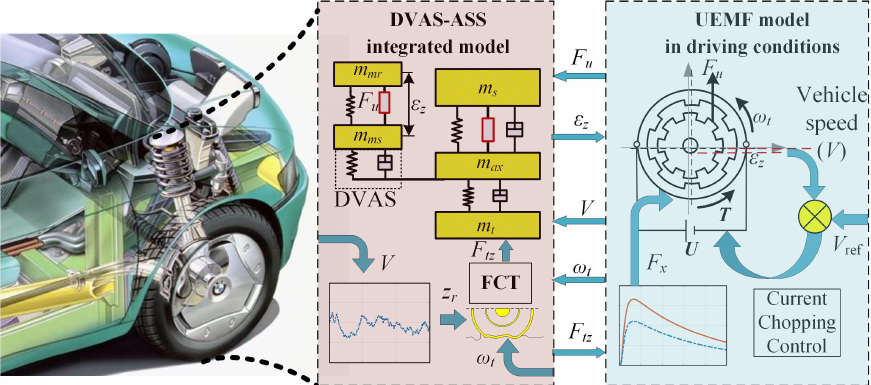
Figure 8. The Multi-field coupling model of IVES.